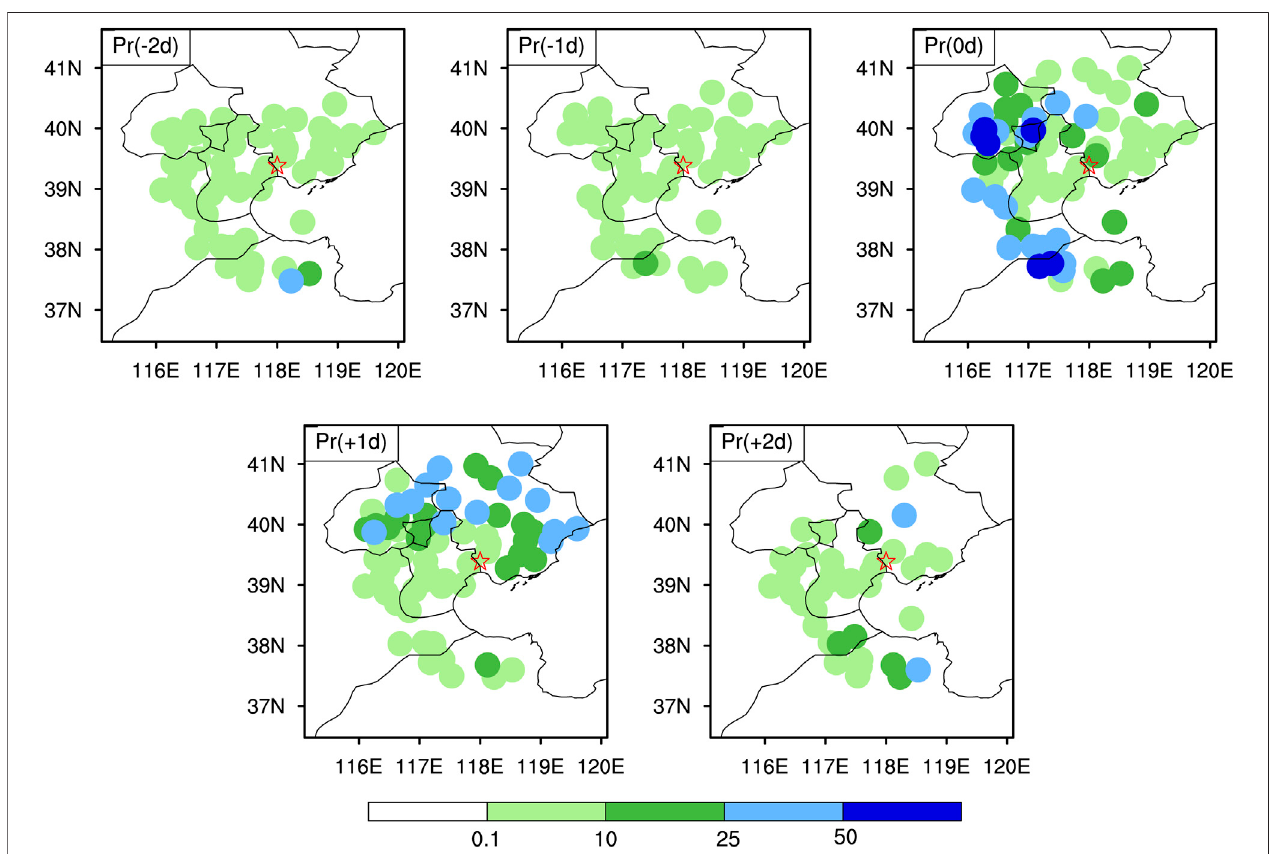
FIGURE 3| Rainfall in the in fl uentialperiod of the Tangshan M s 7.8 earthquake. The red star representsthe epicenter and the colored dots denote different grades of precipitation (units: mm).